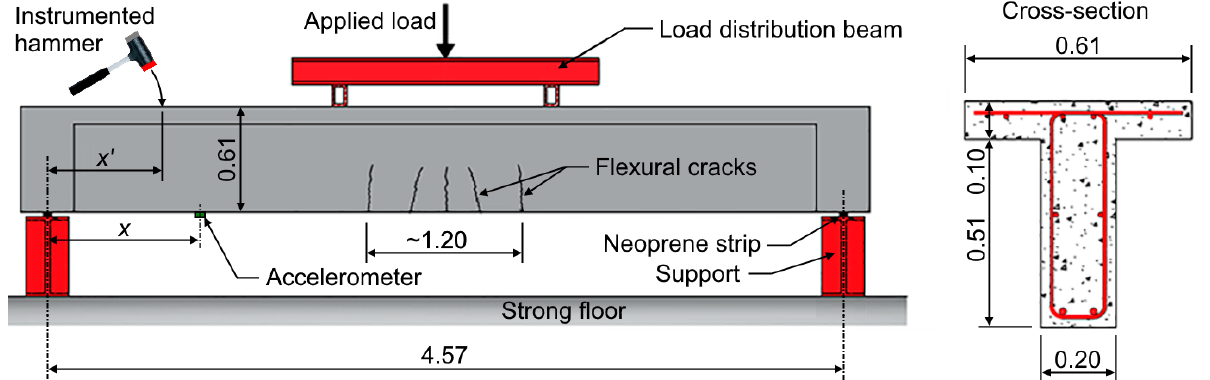
Figure 9. Illustration of experimental test setup. Adapted from [34]. All dimensions in (m).